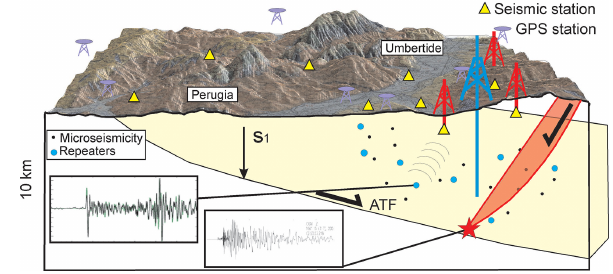
Figure 1. Illustration showing the geological and geophysical char- acteristics of the TABOO test site.